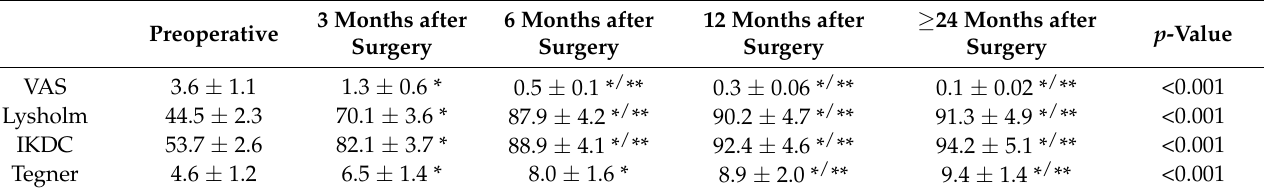
Table 1. Knee pain and function scores at each follow-up time